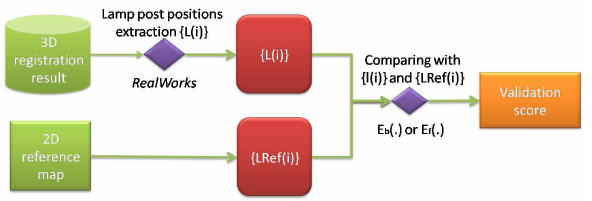
Fig. 7. Feature based quality evaluation ( FBQ ) – general